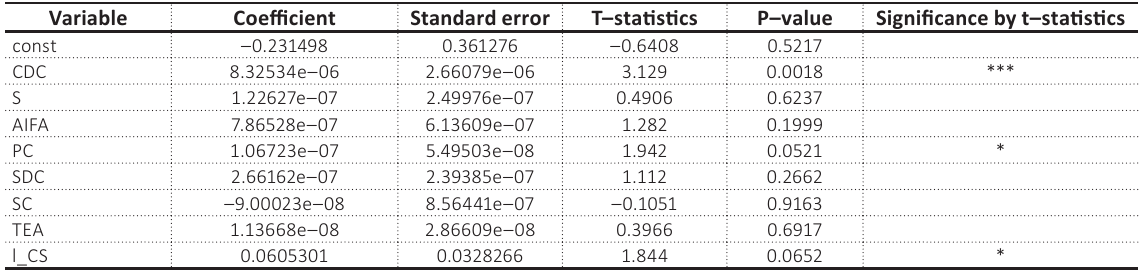
Source: Calculated via Gretl software package.